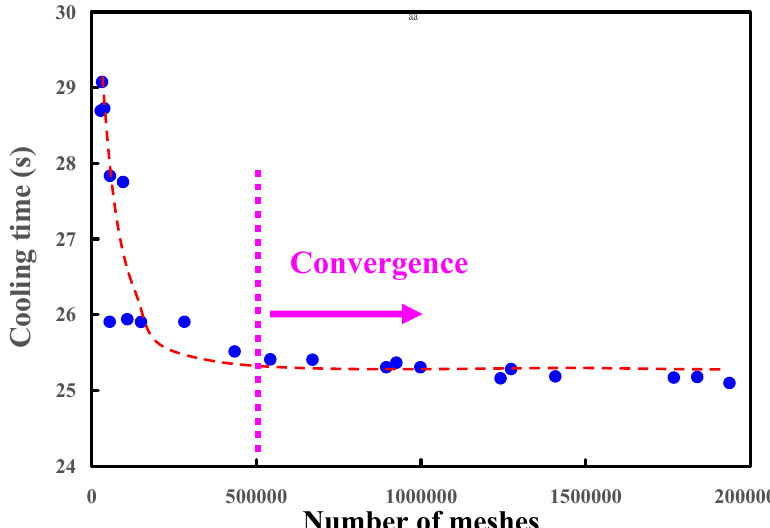
Figure 8. Convergence study of the number of meshes.